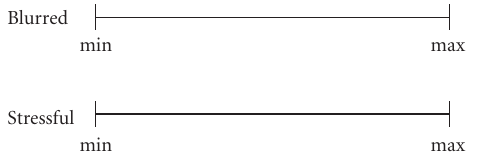
Figure 2: Examples of quality attributes with a related scale in a participant’s individual score